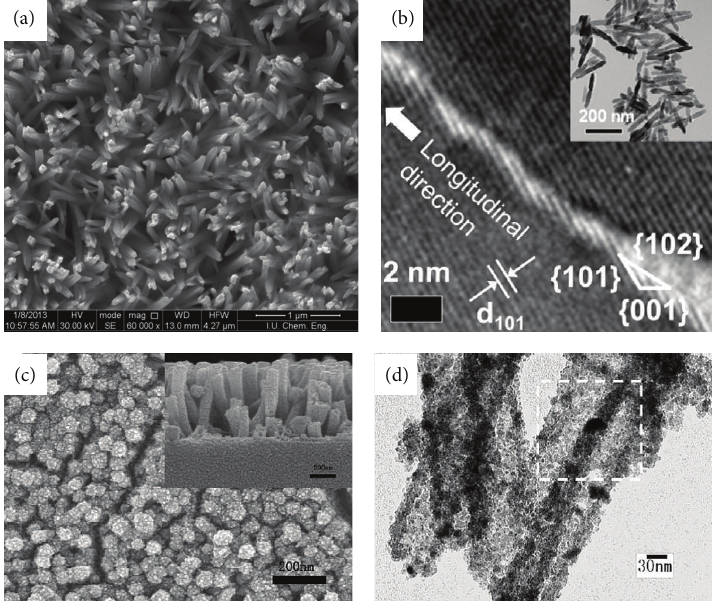
Figure 3: (a) SEM image of Cu 2+ -TiO 2 nanorods, (b) TEM image of N-TiO 2 nanorods [31], (c) FESEM image of N-F-TiO 2 nanorods (inset: its cross section) [32], and (d) TEM image of Au-loaded TiO 2 hollow nanorods